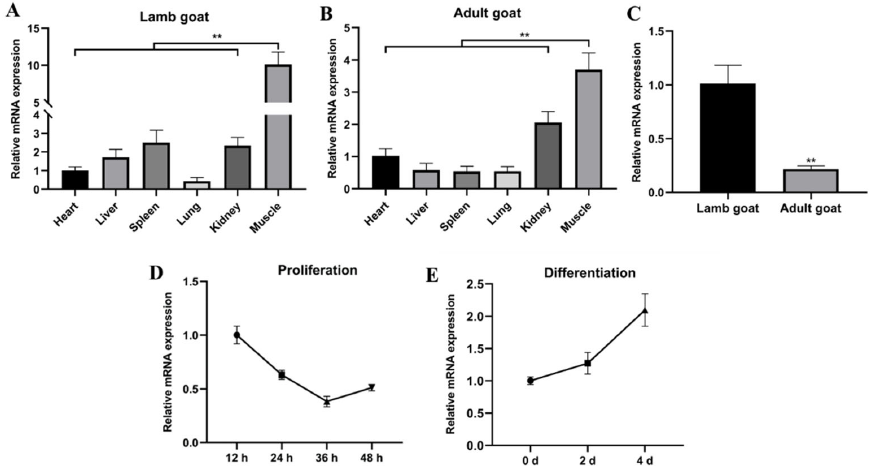
Figure 1. miR-487b-3p is a candidate regulator in goat myogenesis. ( A ) miR-487b-3p expression pattern in different lamb tissues. ( B ) miR-487b-3p expression pattern in different adult goat tissues. ( C ) Comparison of miR-487b-3p expression between lamb and adult goat muscle tissue. ( D ) miR-487b-3p expression pattern during goat myoblast proliferation. ( E ) miR-487b-3p expression pattern during goat myoblast differentiation. Data are shown by mean ± SEM of three independent experiments. ** p < 0.01.